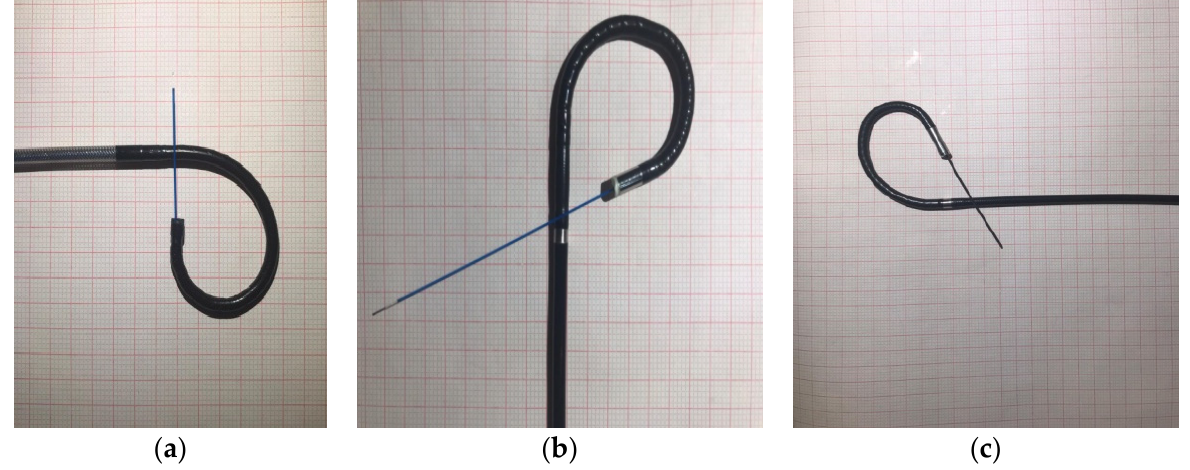
Figure 2. Flexible ureteroscopes USCOPE UE3022 ( a ), URF V ( b ), and URF V2 ( c ); Maximal tip deflection with laser fiber inserted through the working channel.